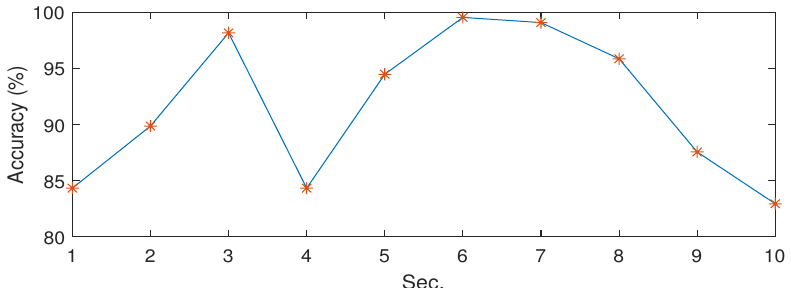
Figure 4. The results of classification for various invariance scales.